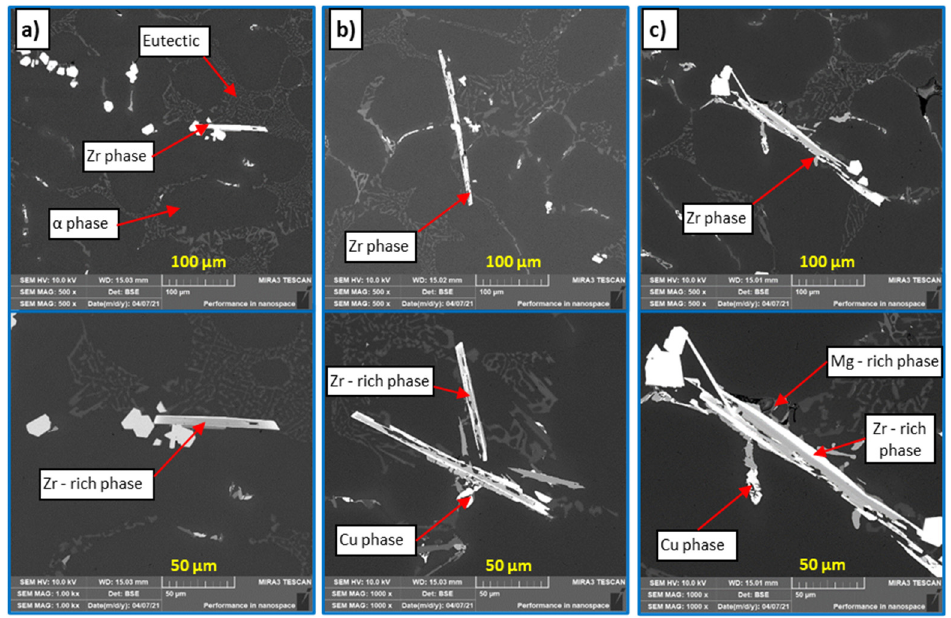
Figure 9. Microstructure of experimental alloys, H 2 SO 4 etch., ( a ) alloy F1 0.1 wt. % Ti in cast state, ( b ) alloy F2 0.2 wt. % Ti in cast state, and ( c ) alloy F3 0.3 wt. % Ti in cast state.